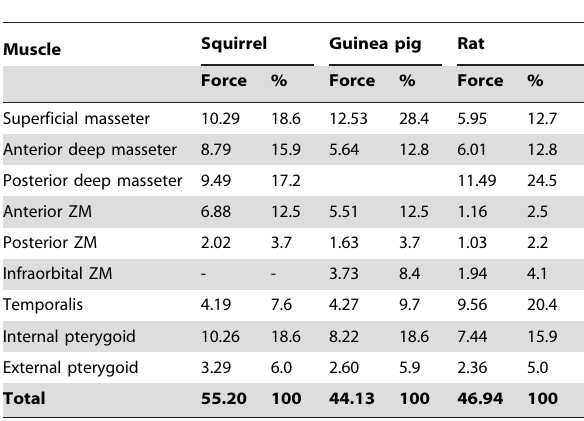
Table 2. Muscle forces (N) applied to each side of each